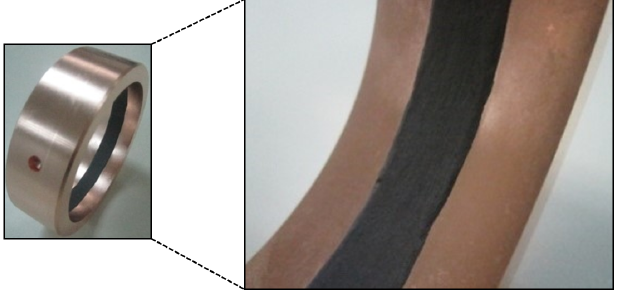
FIG. 3. Load cells with a kind of lossy material (painted in black) coated on the inner wall.